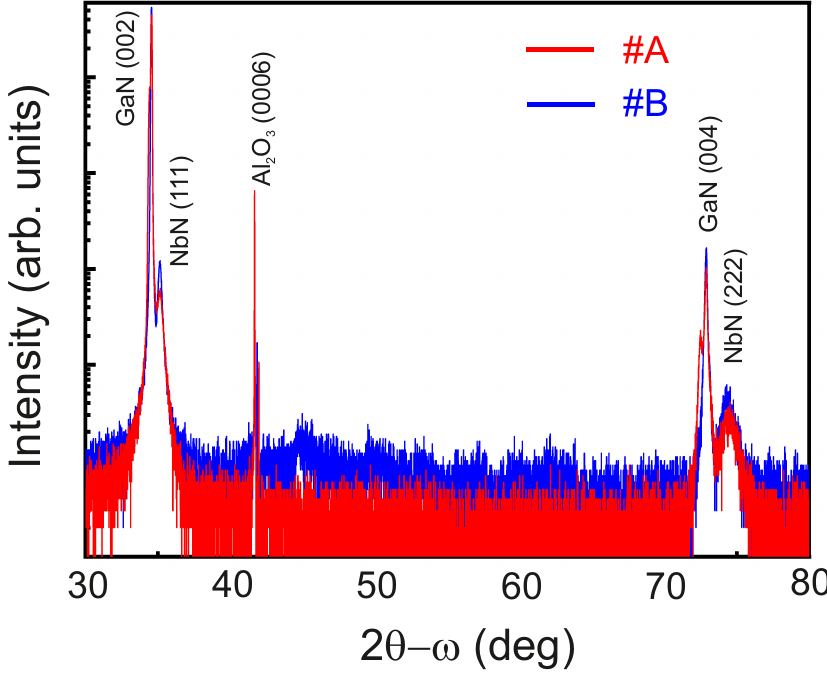
Figure 1. High resolution (2 θ − ω ) scan of #A and